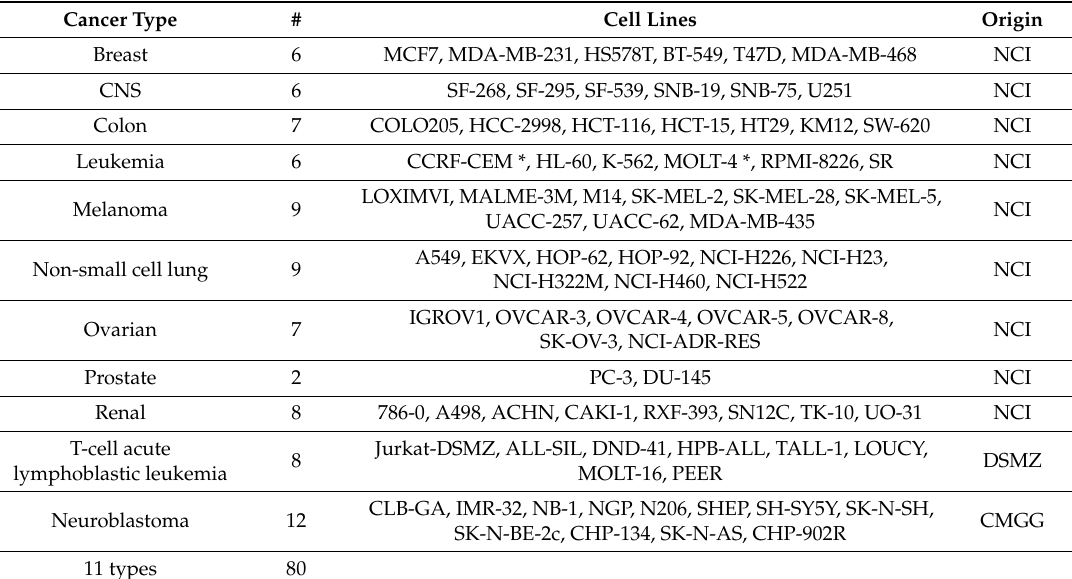
Table 1. Overview of the cell line panel and the cell line